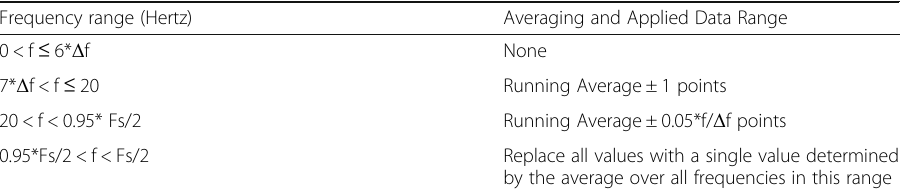
Table 2 Magnitude squared coherence local data averaging procedures over different frequency ranges Frequency range (Hertz) Averaging and Applied Data Range 0 < f ≤ 6* Δ